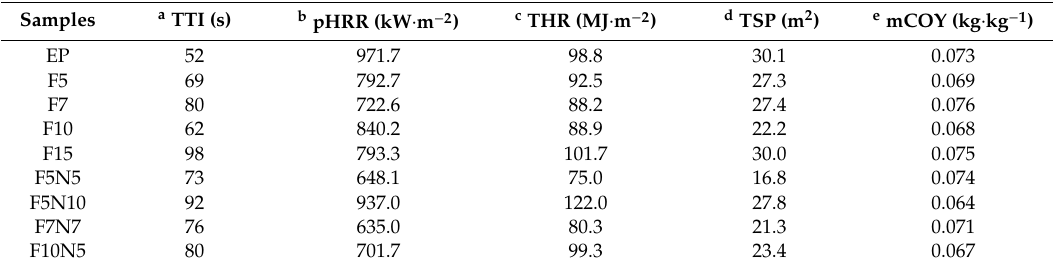
Figure 1. Heat release rate (HRR) of di ff erent samples. ( a ) HRR of epoxy resin (EP), F5, F5N5, and F5N10; ( b ) EP, F7, and F7N7; ( c ) EP, F10, and F10N5; and ( d ) EP, F5N5, F5N10, F7N7, and F10N10. Table 2. Cone calorimeter data of carbon fiber (CF) / EP and carbon nanotubes (CNTs) / CF / EP composites